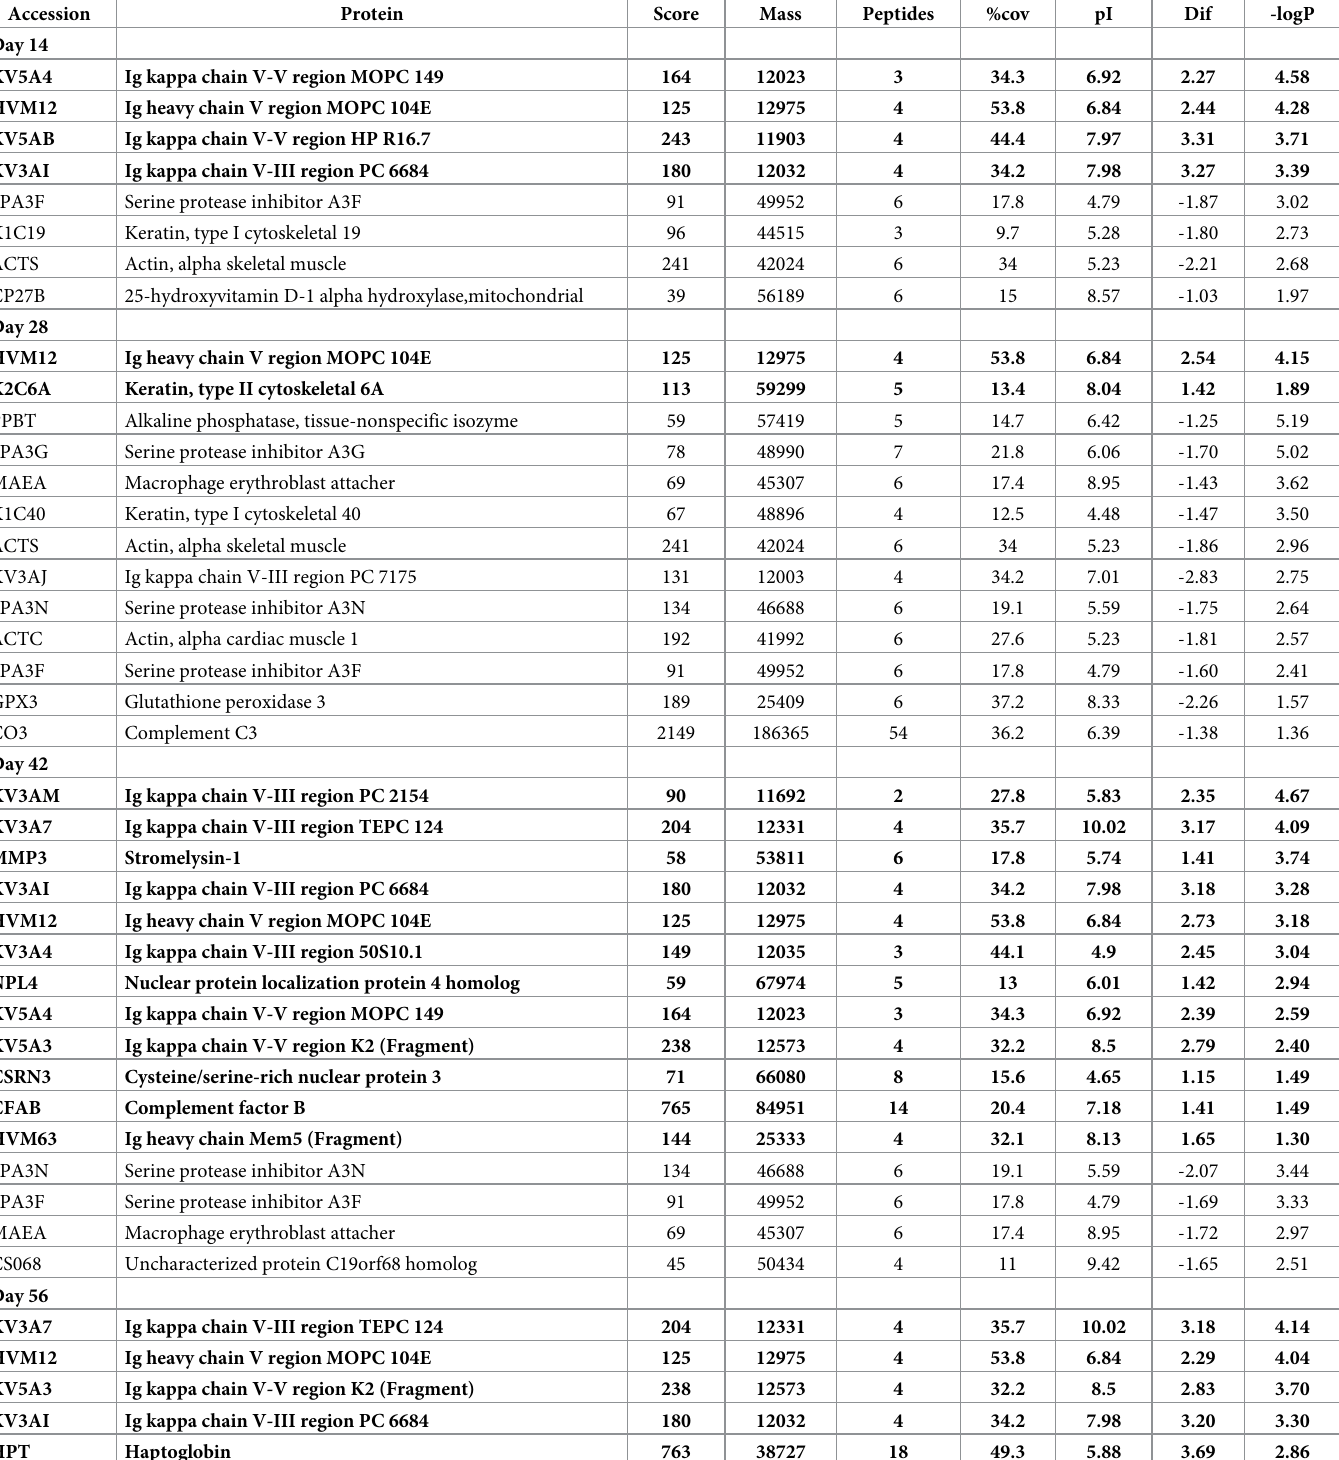
Table 1. Differential mouse serum proteins at 14-, 28-, 42-, and 56-days post-infection with S . mekongi . Up-regulated (bold) and down-regulated proteins were identi- fied by a comparison between uninfected and infected mouse sera using LC-MS/MS and the UniProt protein database. Mus musculus was used as the taxonomy filter. Only significant differences detected in all three mice are shown in this table (p-value �